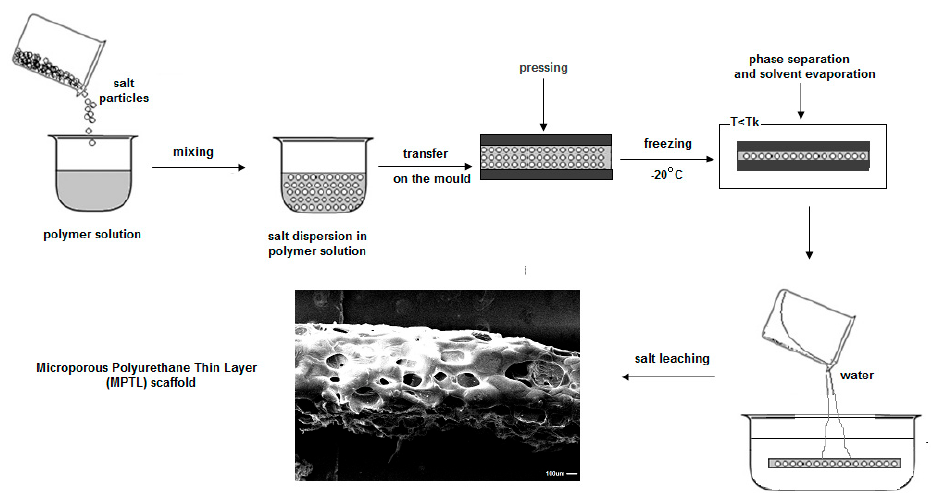
Figure 1. Fabrication steps of MPTL.